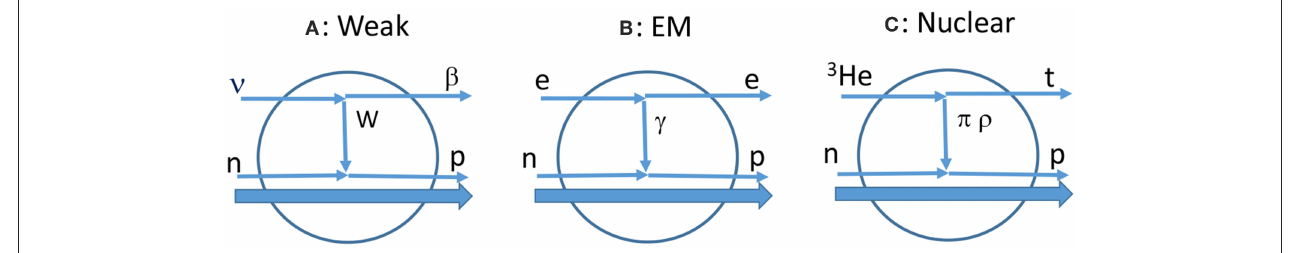
FIGURE 2 | Schematic transition diagrams for β ± decays and EC, neutrino and antineutrino interactions, muon capture reaction of ( µ , ν µ ), nuclear CERs of ( 3 He, t ) and ( d , 2 He) and neutrinoless DBD via a light Majorana neutrino [12].